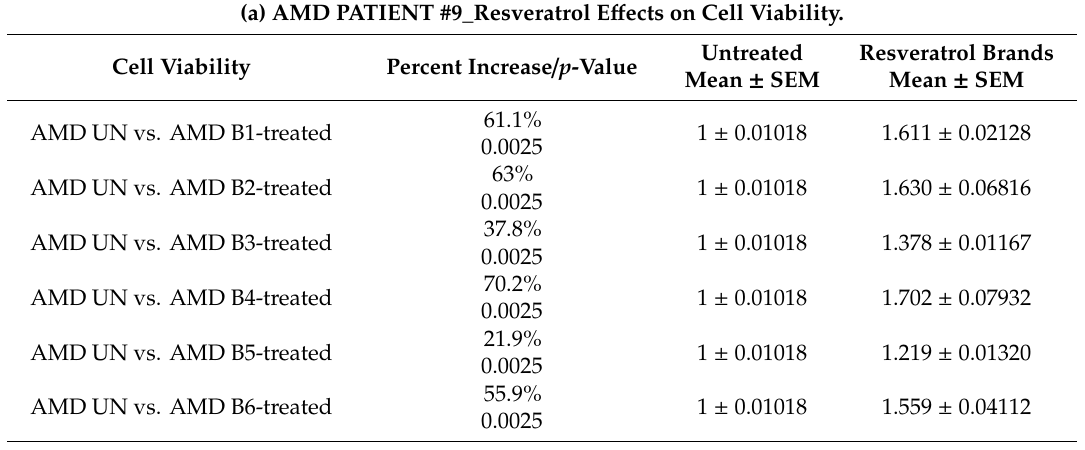
Table 11. E ff ects of resveratrol formulations on cell viability ( a ) and ROS levels ( b ) in AMD patient # 9. (a) AMD PATIENT #9_Resveratrol E ff ects on Cell